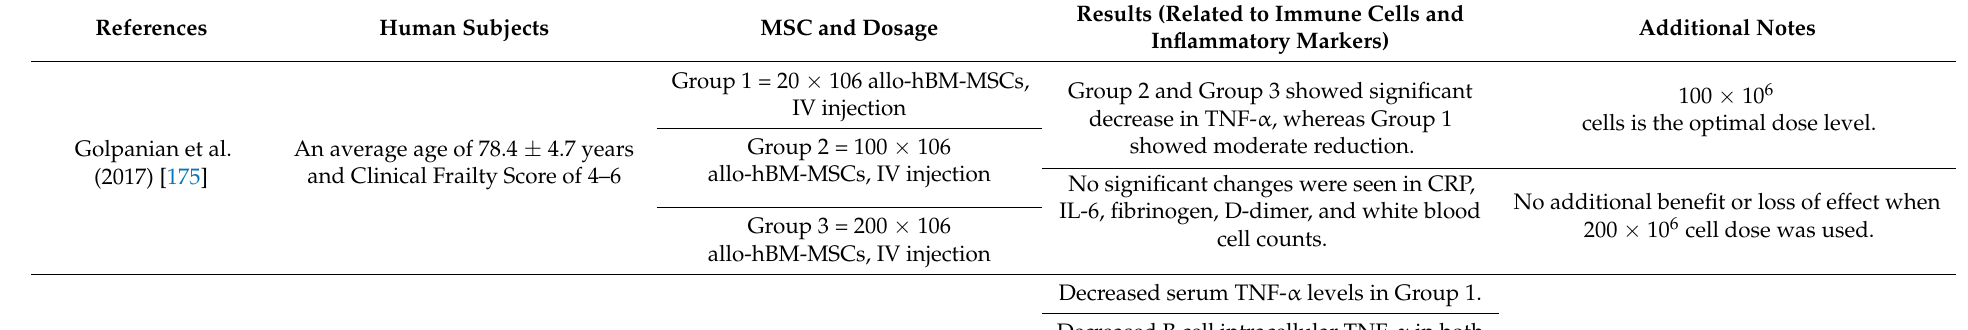
Table 3. A summary of clinical studies of MSC effects on the immune system from